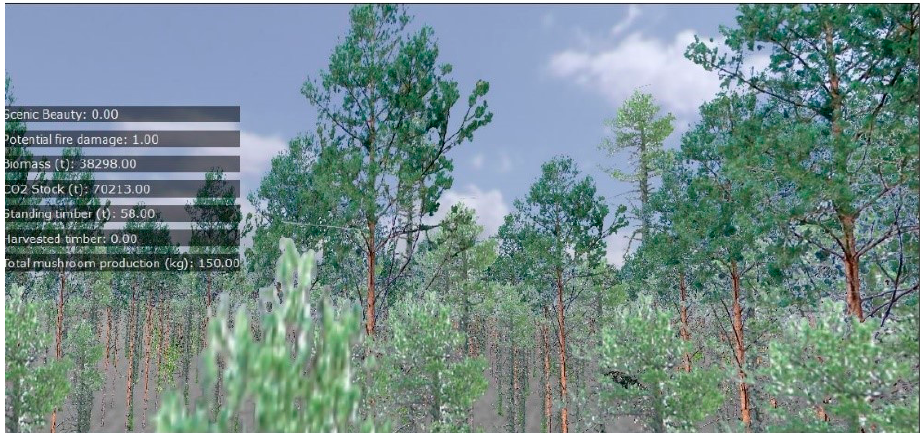
Figure 10. 3D viewer: single stand visualization. The viewpoint is set inside the stand, where a two-stage stand of P. sylvestris can be observed at the 120th year of the simulation using the shelterwood method. The left panel is used to show ecosystem service values for this year of the simulation. By clicking on each tree object, its information can be seen in the left corner of the window, above the scene.